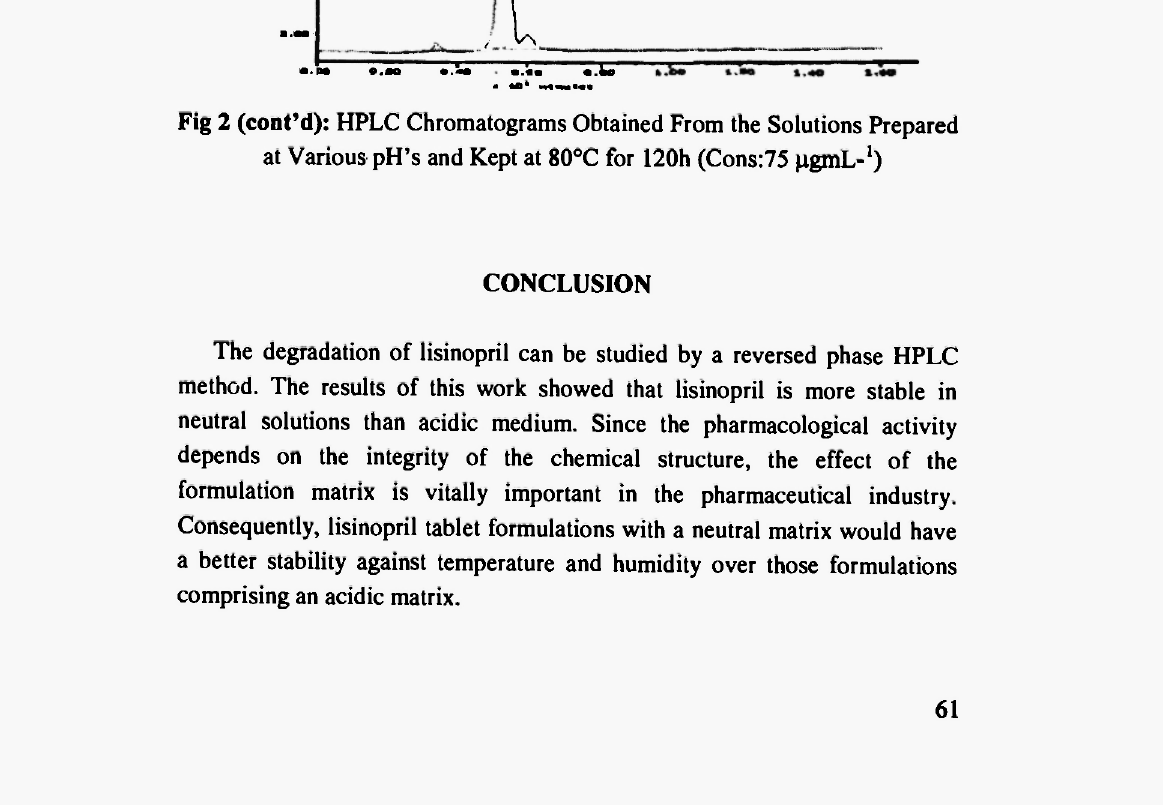
Fig 2 (cont'd): HPLC Chromatograms Obtained From the Solutions Prepared at Various pH's and Kept at 80°C for 120h (Cons:75 μ ^ Ι , - 1